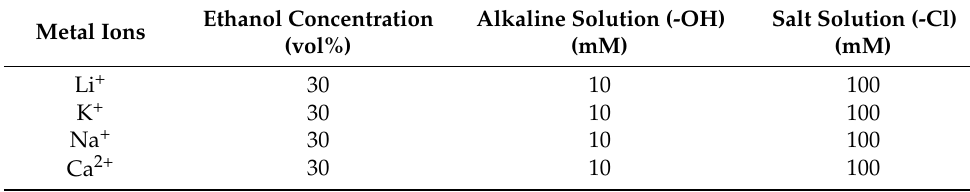
Table 2. The composition of different types of metal ions in the conditioning